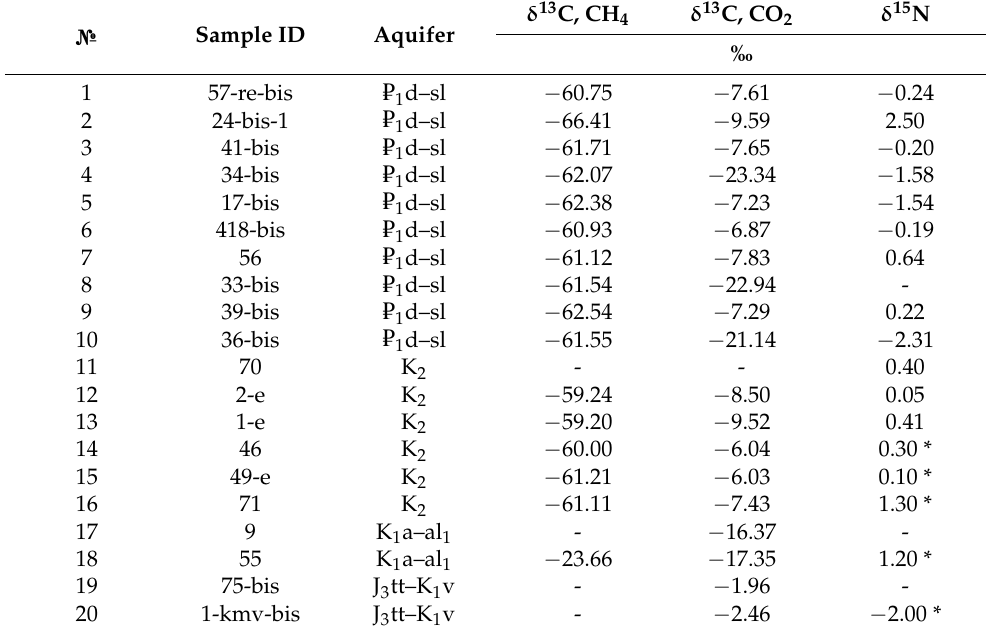
Table 6. Isotopic composition of free gases of natural mineral water of the Essentuki field.